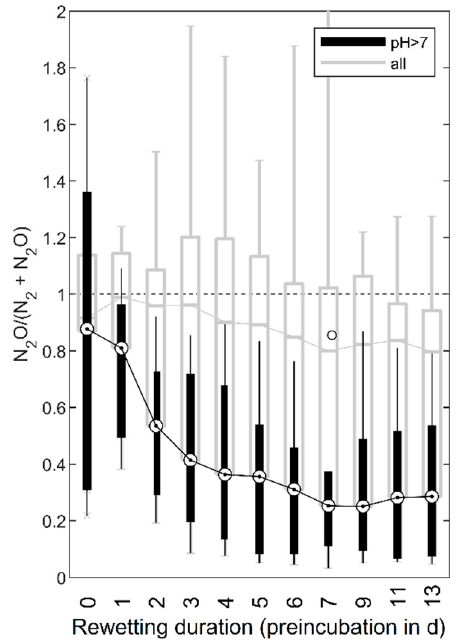
Figure 2. Boxplots of denitrification product ratios (N 2 O / (N 2 O + N 2 )) after di ff erent periods of rewetting for the entire soil sample subset (grey) compared with the soils from pH class > 7 (black). The boxplots show the inter-quartile-range (box = 25th to 75th percentile with median (50th percentile)), 90th and 10th percentile (upper and lower whisker), and outliers (circle).